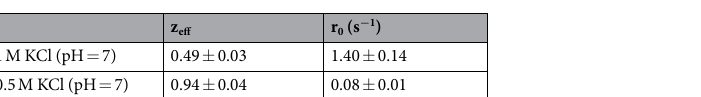
Table 2. Estimated values for the capture rate of the dendrimer (r 0 ) by the α -HL at equilibrium ( Δ V → 0), and the effective valence (quantified by z eff ) of the dendrimer’s surface in contact with the α -HL’s lumen opening, during